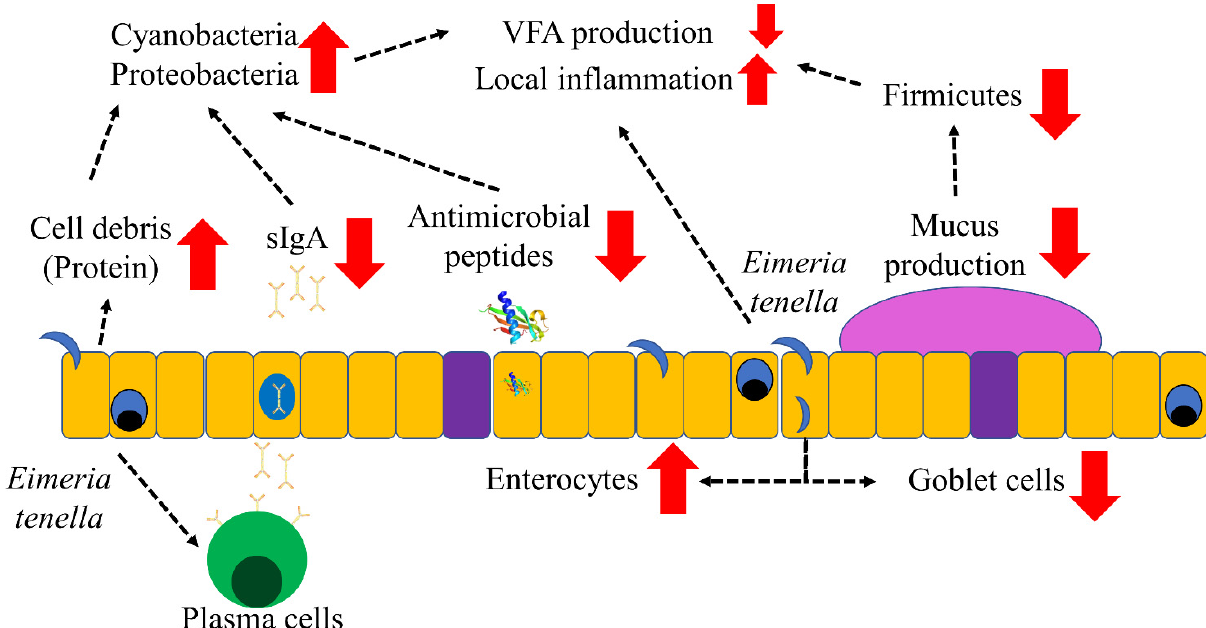
Figure 13. Summary of the interactions of microbiota and mucosal immunity in the ceca of broiler chickens infected with Eimeria tenella. Infection of Eimeria tenella increased protein concentrations potentially by increasing cell debris in the cecal contents. Eimeria tenella infection reduced concen- trations of secretory immunoglobulin A (sIgA) and antimicrobial peptides. These factors would have increased the relative abundance of the phylum Proteobacteria and Cyanobacteria, considered pathogenic bacteria. Eimeria tenella infection reduced goblet cell density, which would have reduced mucus production in the ceca. This would have resulted in reducing the relative abundance of the Firmicutes, which use mucus for colonization and have important roles in degrading fiber and pro- ducing volatile fatty acids in the ceca. Eimeria tenella infection with negatively modulated microbiota would have induced local inflammation in the ceca of broiler chickens.